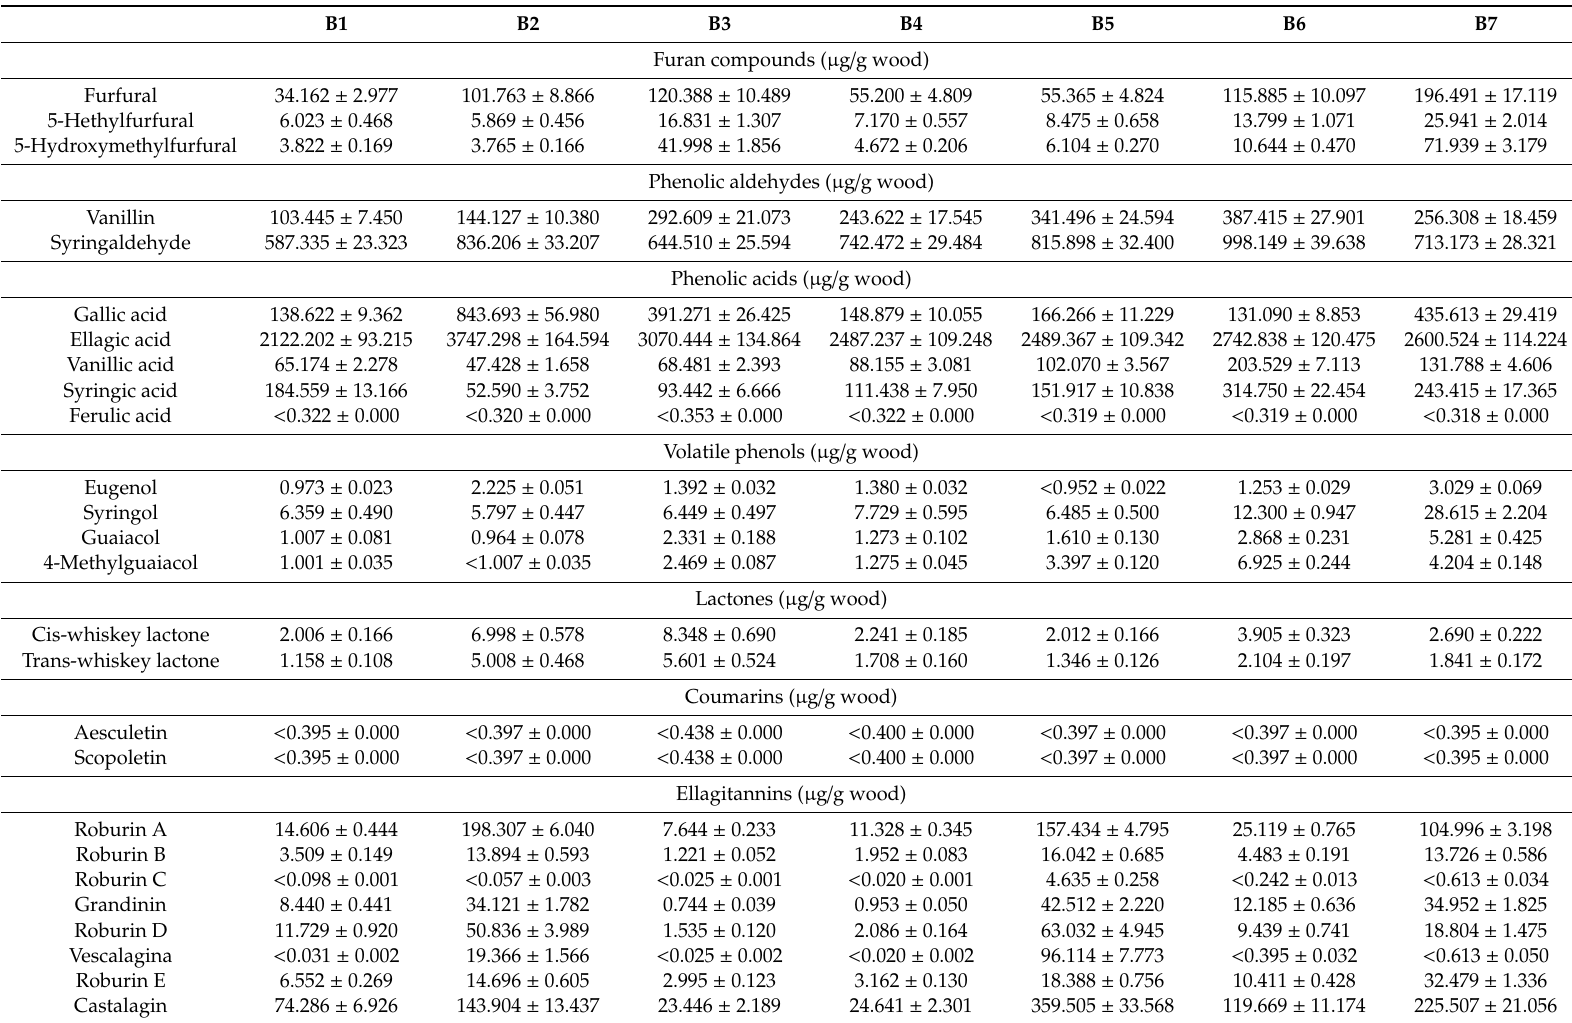
Table 5. Aromatic composition of the used barrels after the cleaning